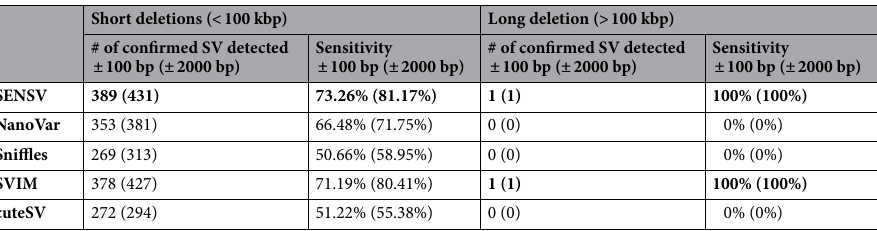
Table 2. The performance of SENSV, NanoVar, Sniffles, SVIM and cuteSV on detecting SVs in HG002 with breakpoint precision of 100 bp and 2000 bp respectively. The benchmark set of HG002 contains 531 confirmed short deletions with size of smaller than 100 kbp and one long deletion with size of larger than 100 kbp. The sensitivity inside the paratheses is measured with the relaxed breakpoint precision of 2000 bp. The best results of a row are in